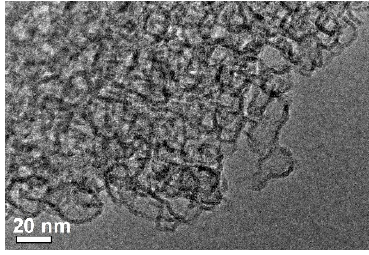
Figure 1. TEM image of Si-doped graphene nanoflakes